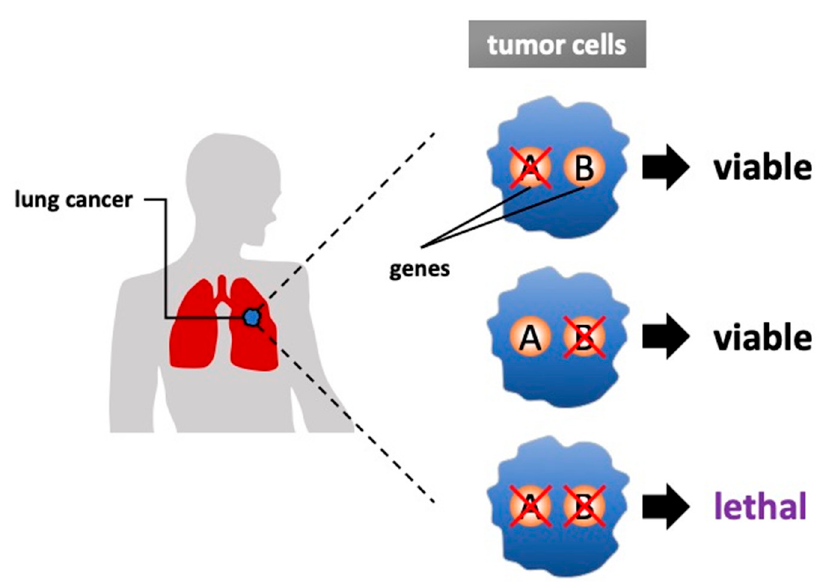
Figure 1. Synthetic lethality in lung cancer. Two genes are defined as synthetically lethal if simultaneous mutations of both genes cause cell death while sparing normal cells. Most cancers harbor one or more gene mutations that are categorized as loss-of-function or gain-of-function, and synthetic lethality is targeting these combinations. Basically, a genetics-based approach and a drug-based approach are used for the research to identify the targetable